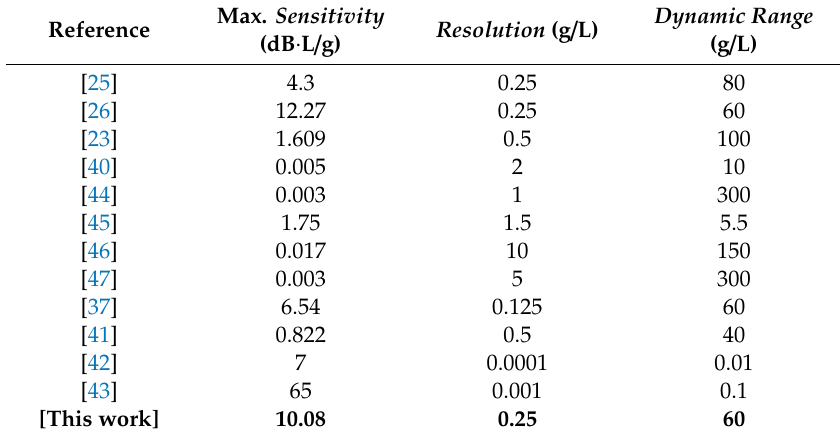
Table 1. Comparison of various microwave fluidic sensors for solute concentration measurement in liquid